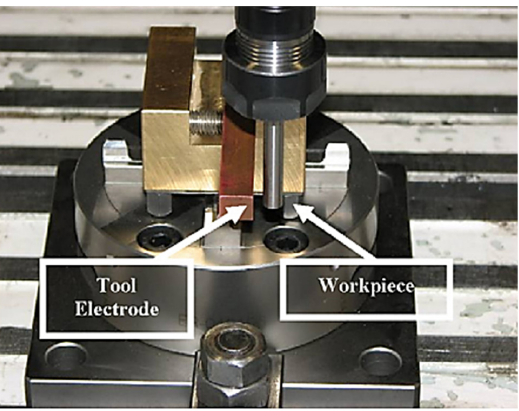
Figure 5. Experimental setup (Reprinted/Adapted with permission from [28]. 2008, Elsevier.©).